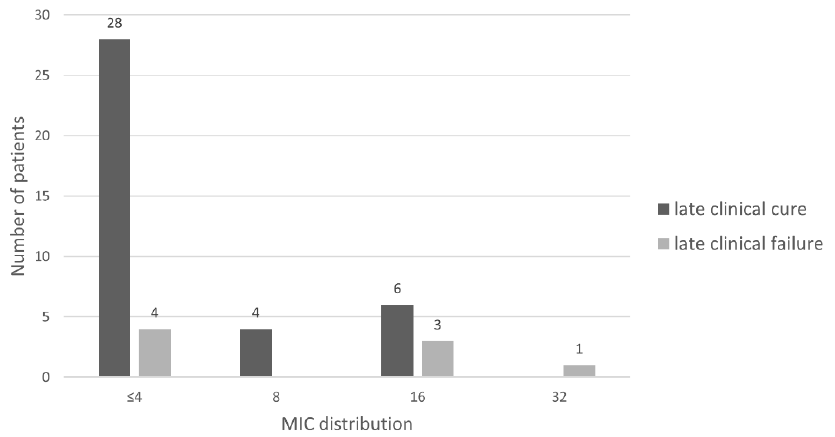
Figure 1. MIC distribution for primary outcome: late clinical cure ( n = 46). MIC = minimal inhibitory concentration.